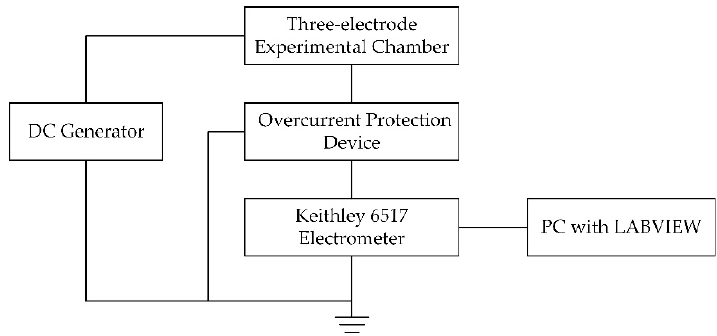
Energies 2019 , 11 , x FOR PEER REVIEW